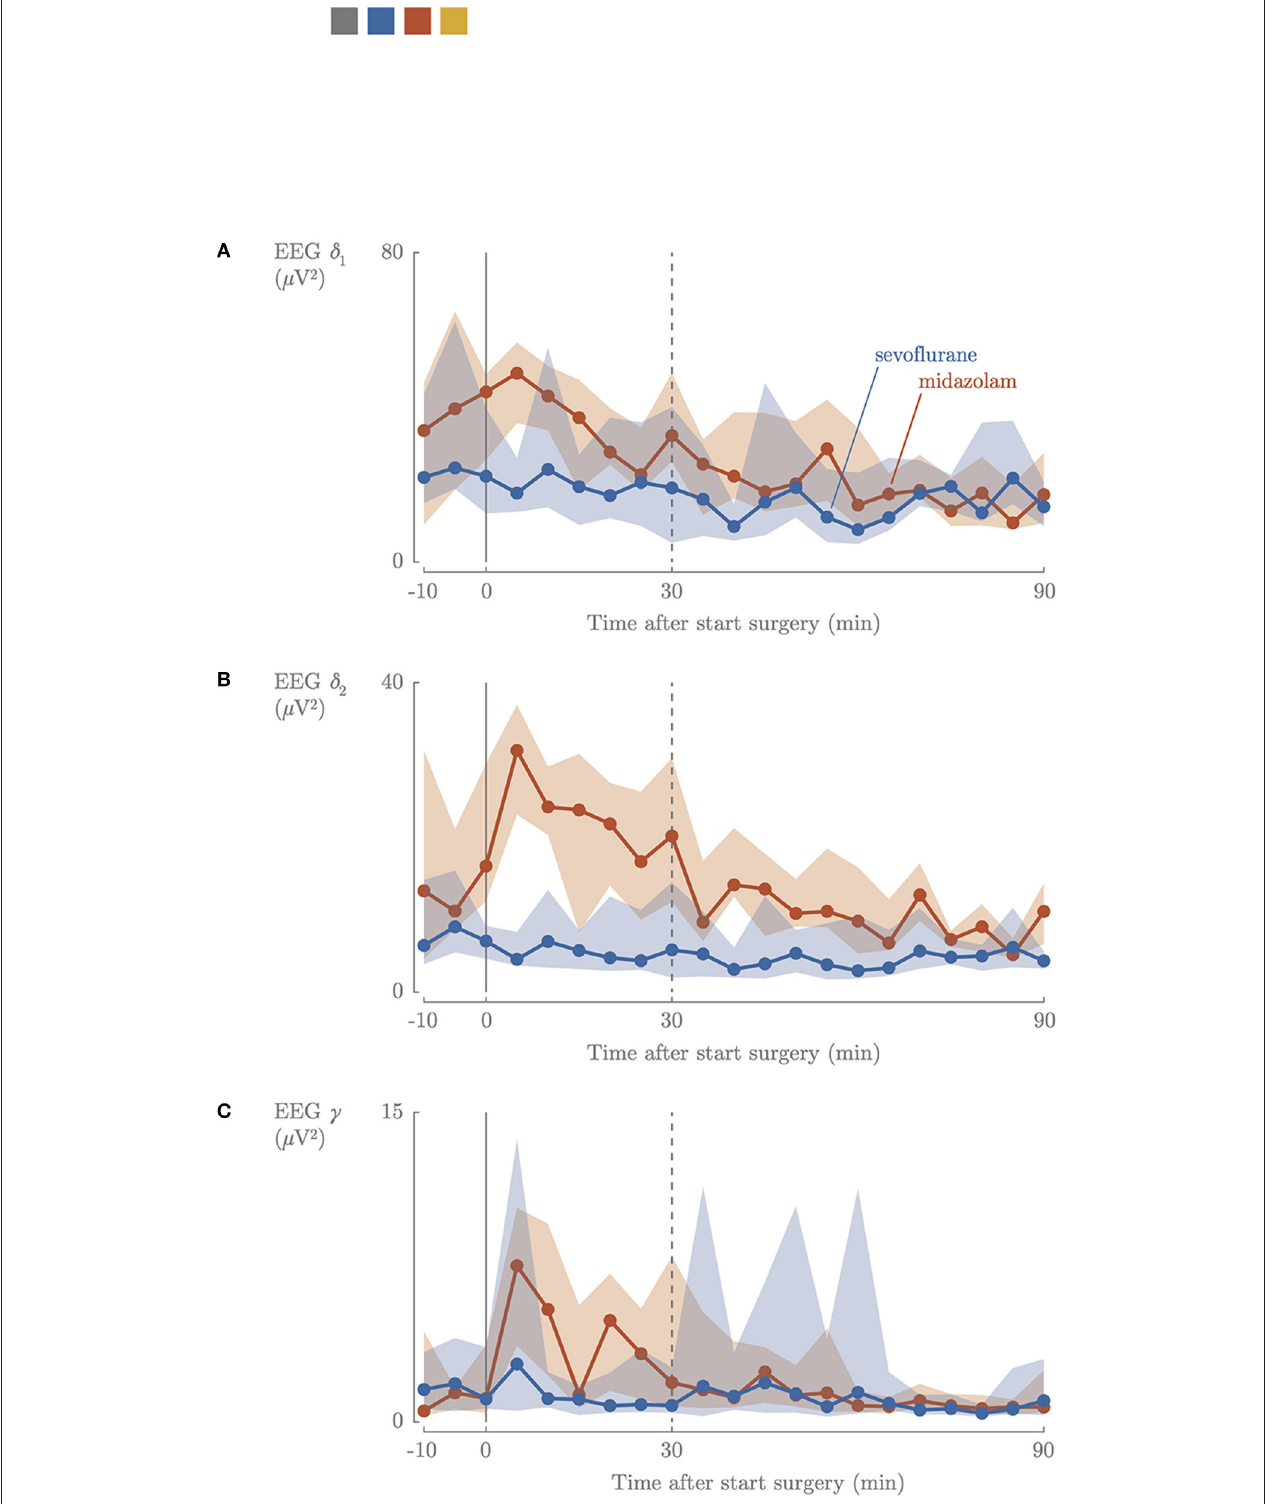
FIGURE 2 | Intraoperative cerebral activity; slow delta (A) , fast delta (B) , gamma (C) power. Blue, sevoflurane group; red, midazolam group; 0, start surgical procedure.